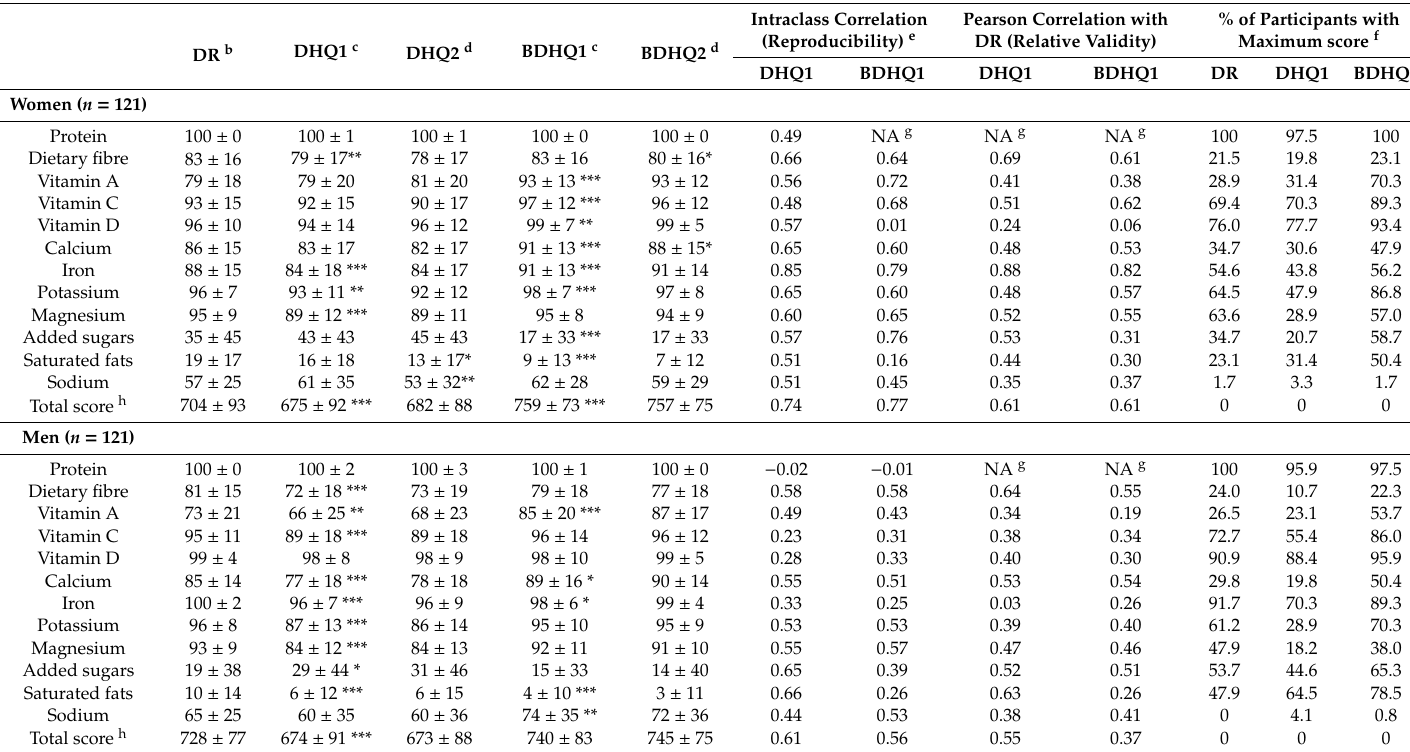
Table 3. Component and total scores of the Nutrient-Rich Food Index 9.3 estimated from a 16-day weighed dietary record (DR) conducted over a year